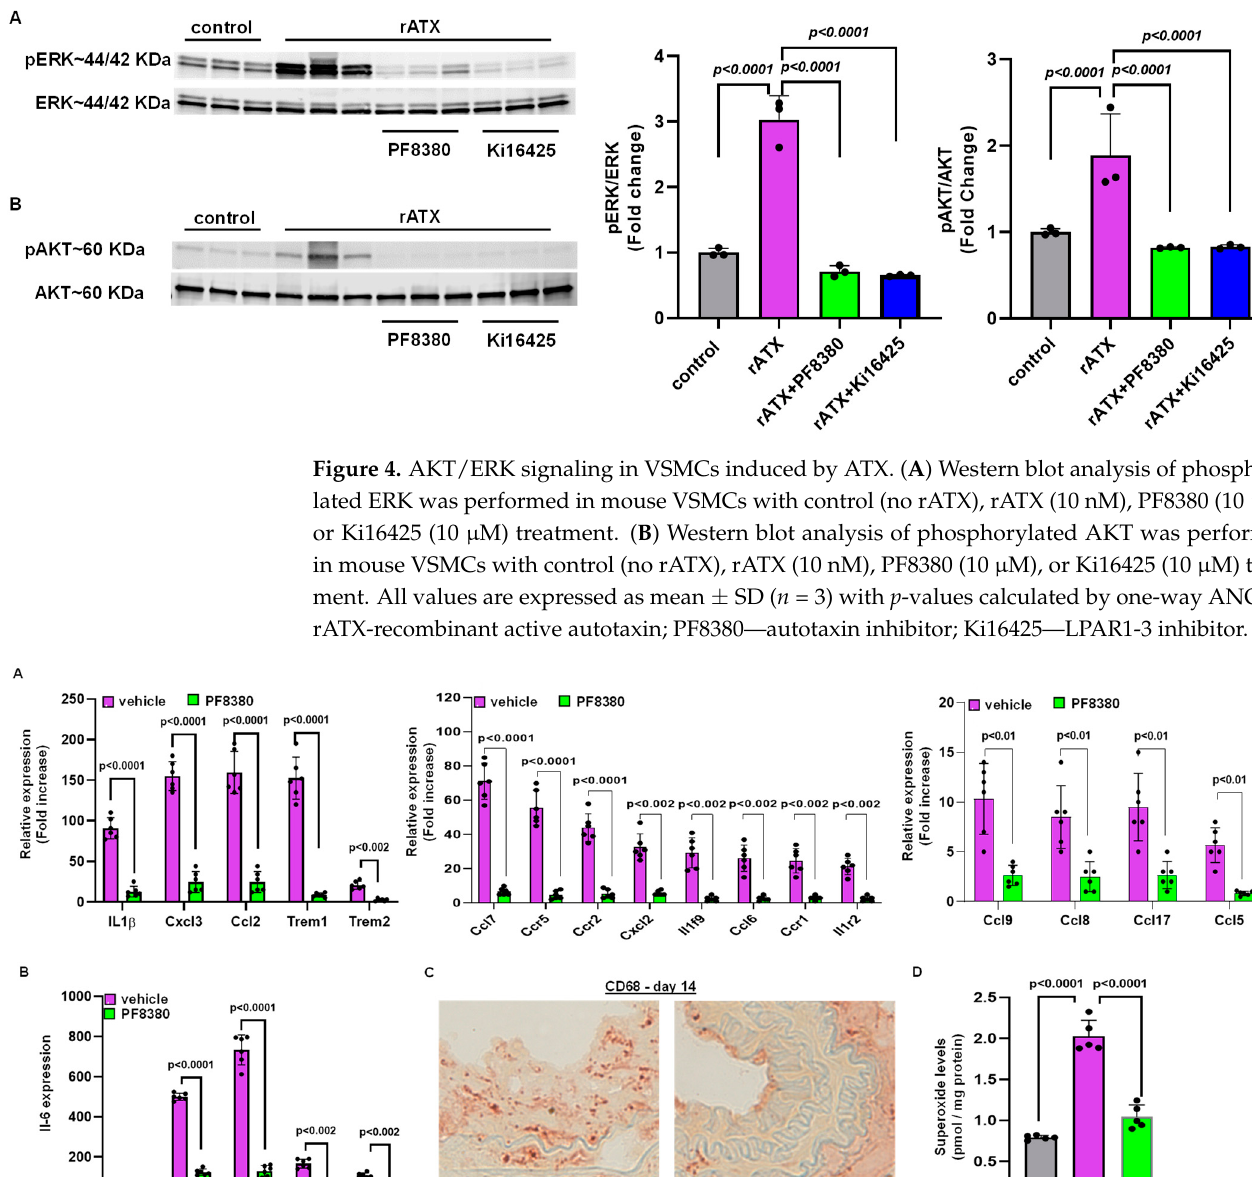
carotid artery, were inhibited considerably ( p < 0.0001) with PF8380 treatment (Figure 5D).